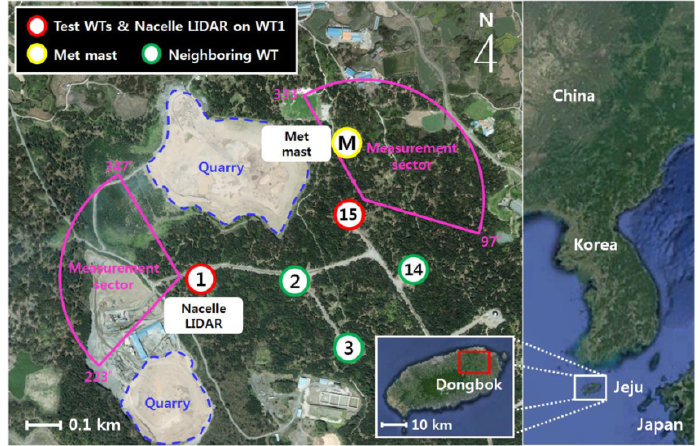
Figure 1. Location of Jeju Island including the layout of wind turbines and instruments at Dongbok wind farm.